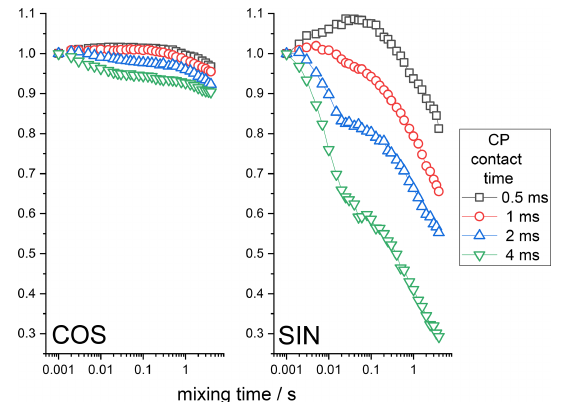
Figure 5. COS and SIN components of the 15 N CSA CODEX mix- ing time dependence measured at various CP contact times in BOC glycine. The initial amplitudes of the τ m dependences were normal- ized to the same value. MAS 20kHz, NT R 2ms, 108kHz 1 H CW decoupling during the de(re)phasing periods.